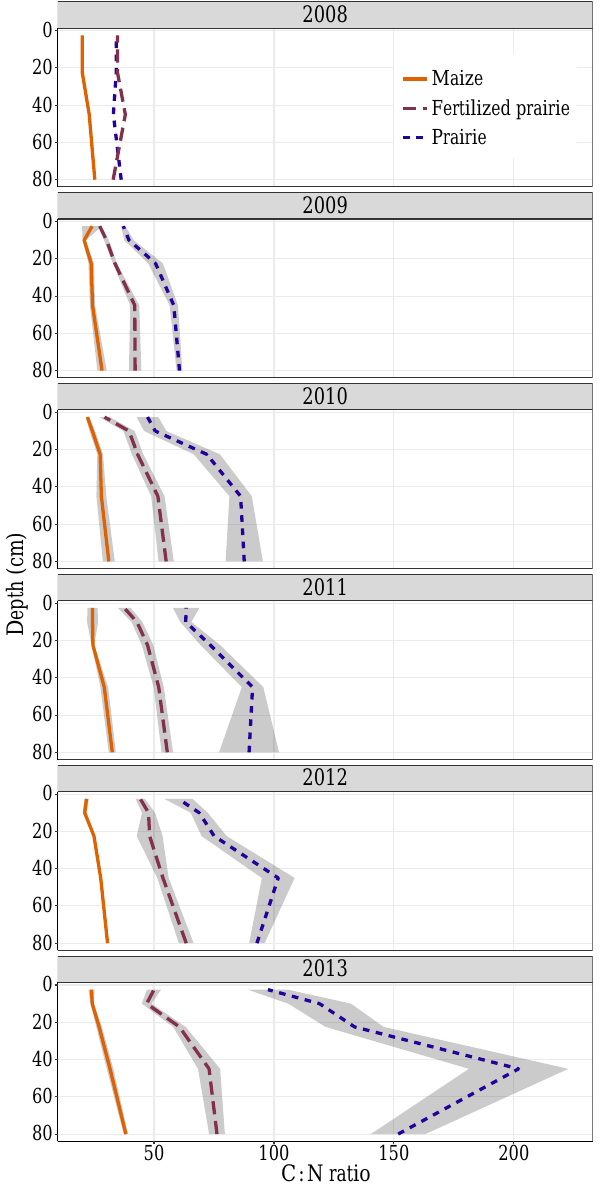
Figure 5. Root C : N ratios with depth over time. Grey shading rep- resents 1 standard error of the